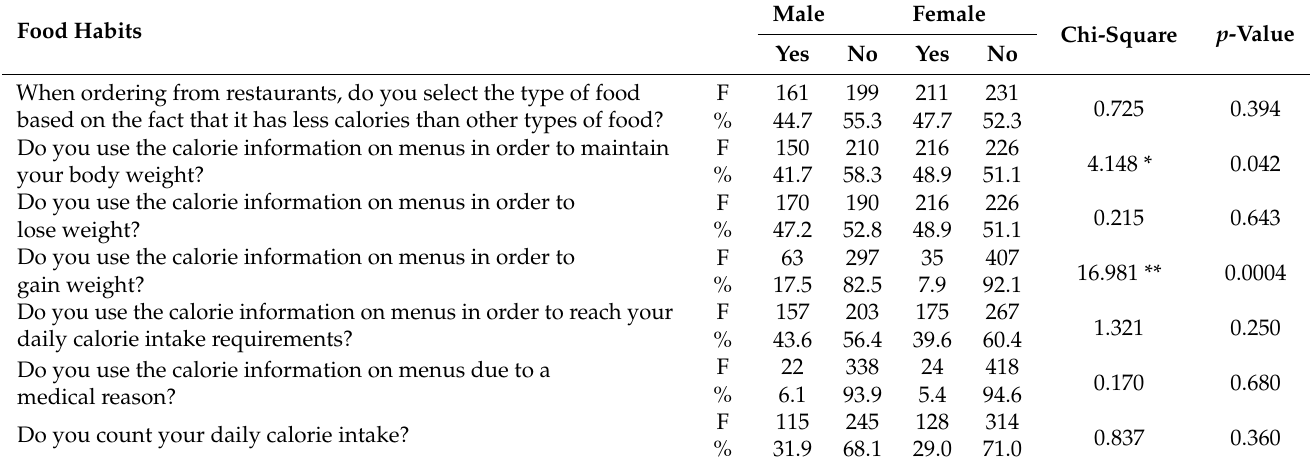
Table 2. Effects of calorie labeling on food habits of Male ( n = 360) and Female ( n = 442)